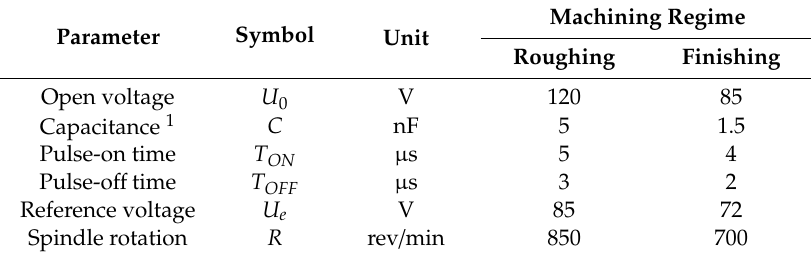
Table 2. Wire electrical discharge grinding (WEDG) processing parameters.